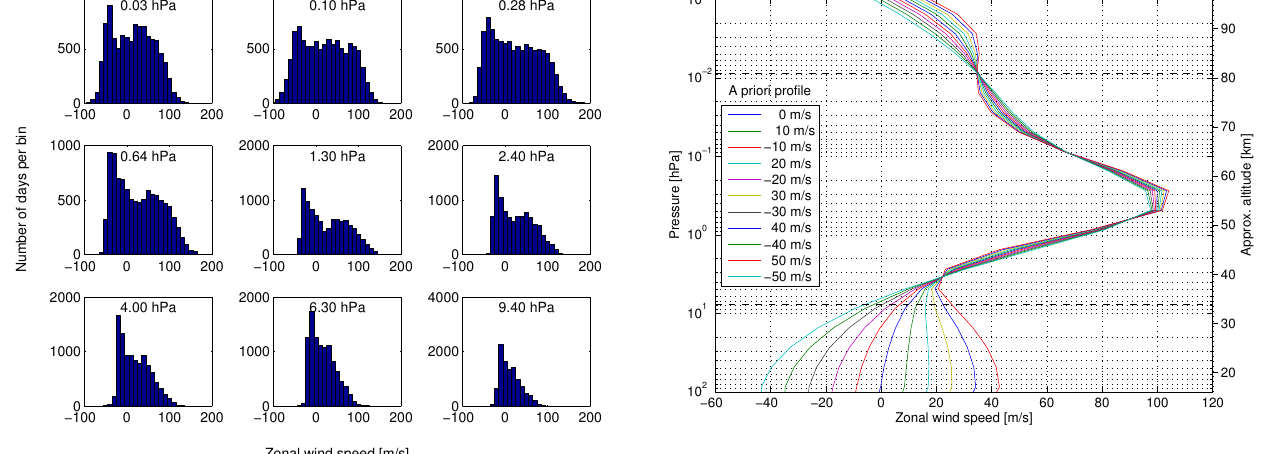
Figure 7. Influence of different choices of constant a priori wind profiles (indicated in the legend box) on the retrieval result for a real measurement example (23 November 2013). The dashed horizontal lines represent the limits where the measurement response is higher than 0.8. Within this altitude range the influence of the choice of the a priori profile is